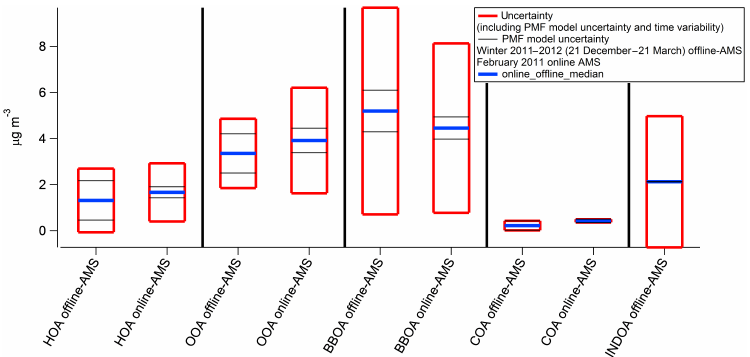
Figure 7. Online- (PM 1 ) and offline-AMS (PM 2 . 5 ) comparison for winter. Bars represent the error including temporal variability and model uncertainty.